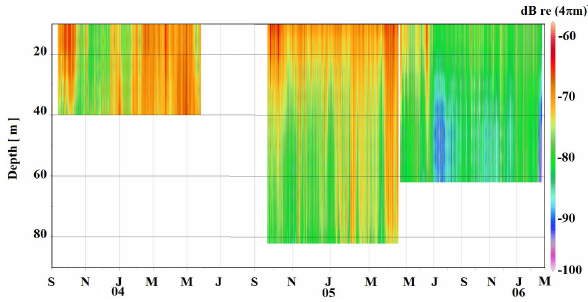
Fig. 6. Time series of daily mean backscatter strength data recorded during the three deployments. Year is indicated below January label.